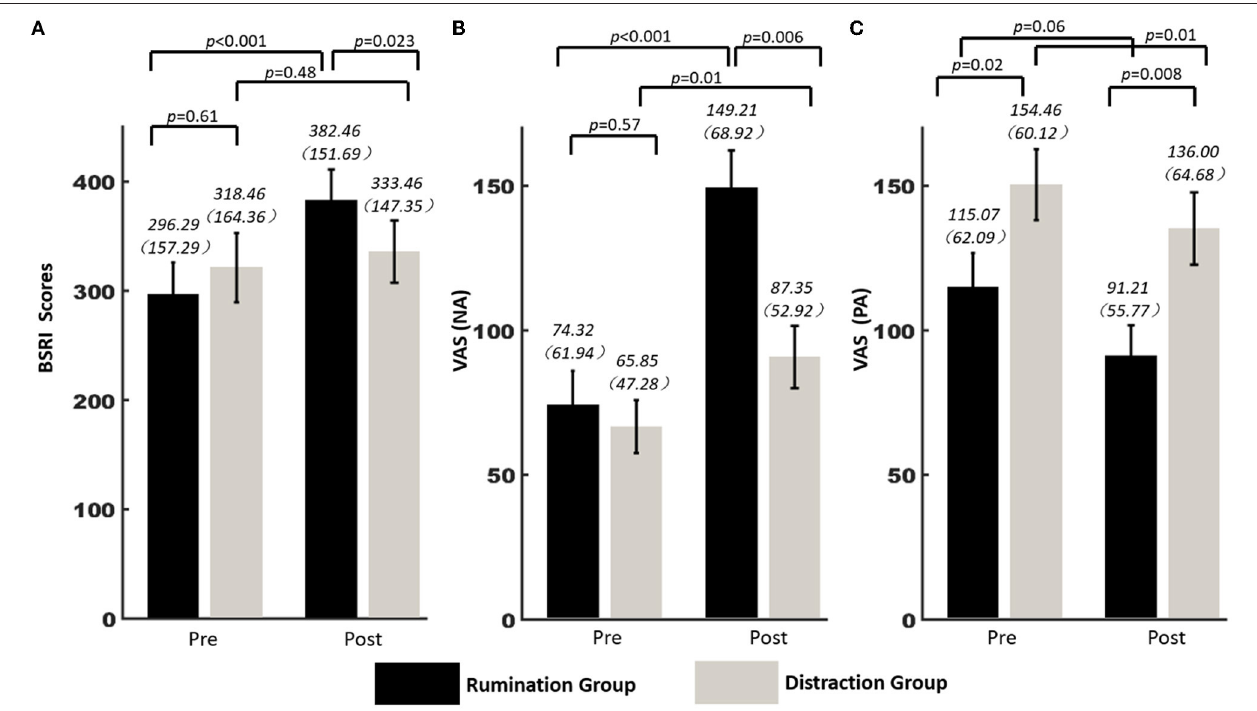
FIGURE 1 | ANOVA results of negative and positive emotion assessment and rumination degree before and after the experiment in Sample 2. (A) BSRI scores of rumination group and distraction group before and after the experiment. (B) Negative emotion scores of rumination group and distraction group before and after the experiment. (C) Positive emotion scores of rumination group and distraction group before and after the experiment. NA, negative affect; PA, negative affect; Pre, before the experiment; Post, after the experiment.